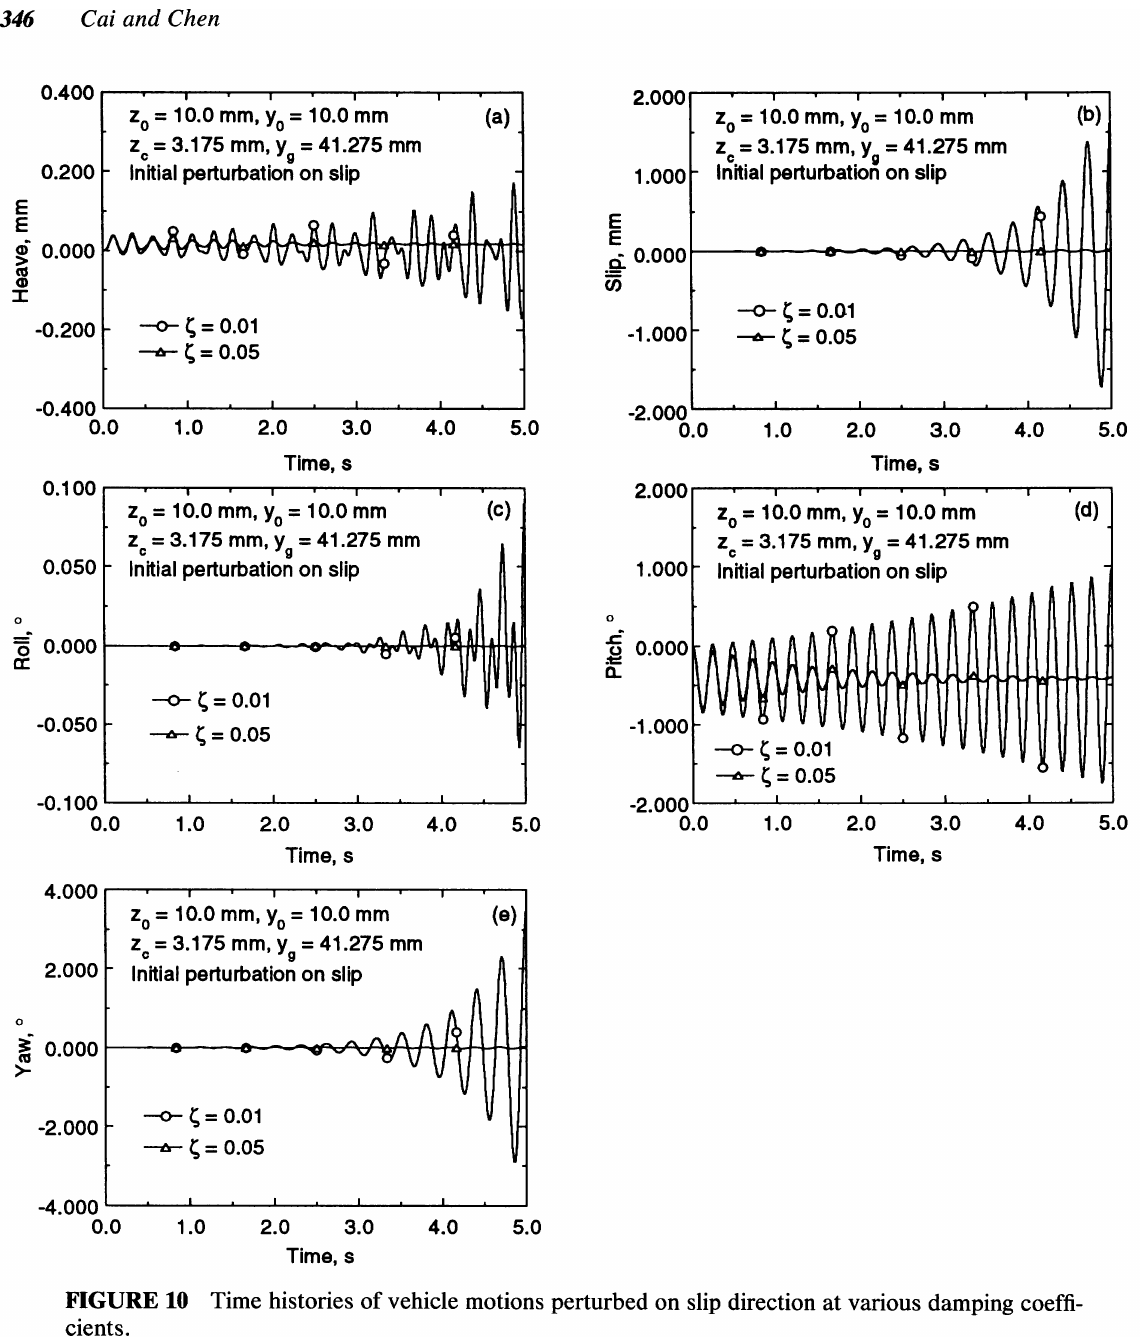
FIGURE 10 Time histories of vehicle motions perturbed on slip direction at various damping coeffi